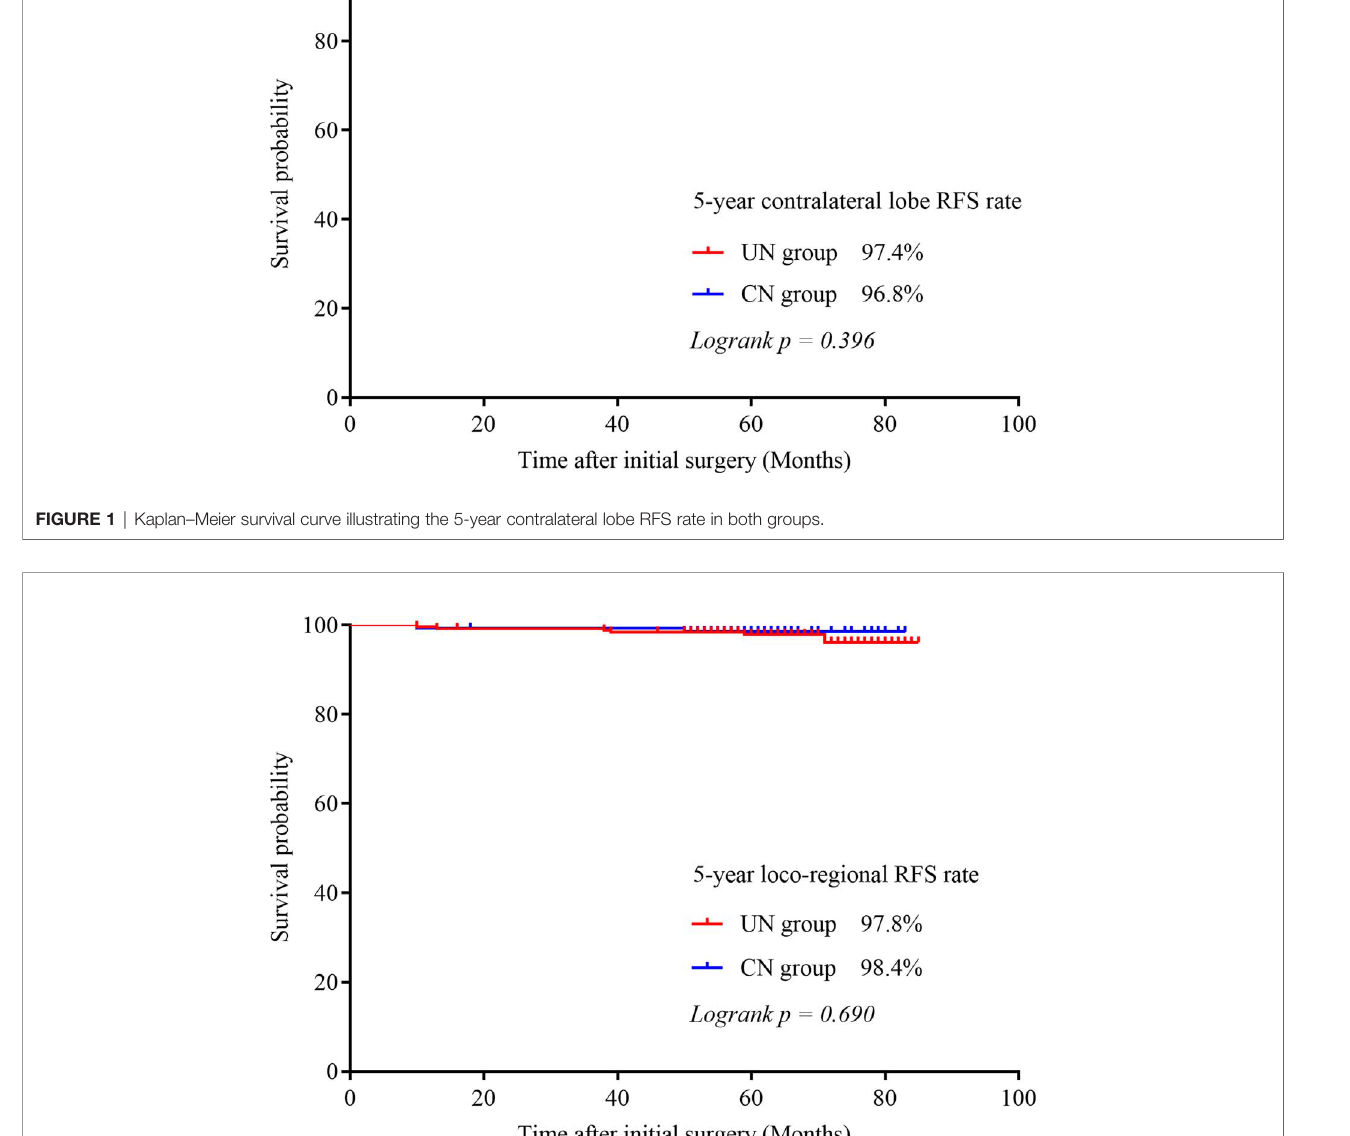
FIGURE 2 | Kaplan – Meier survival curves illustrating the 5-year loco-regional RFS rate in the two